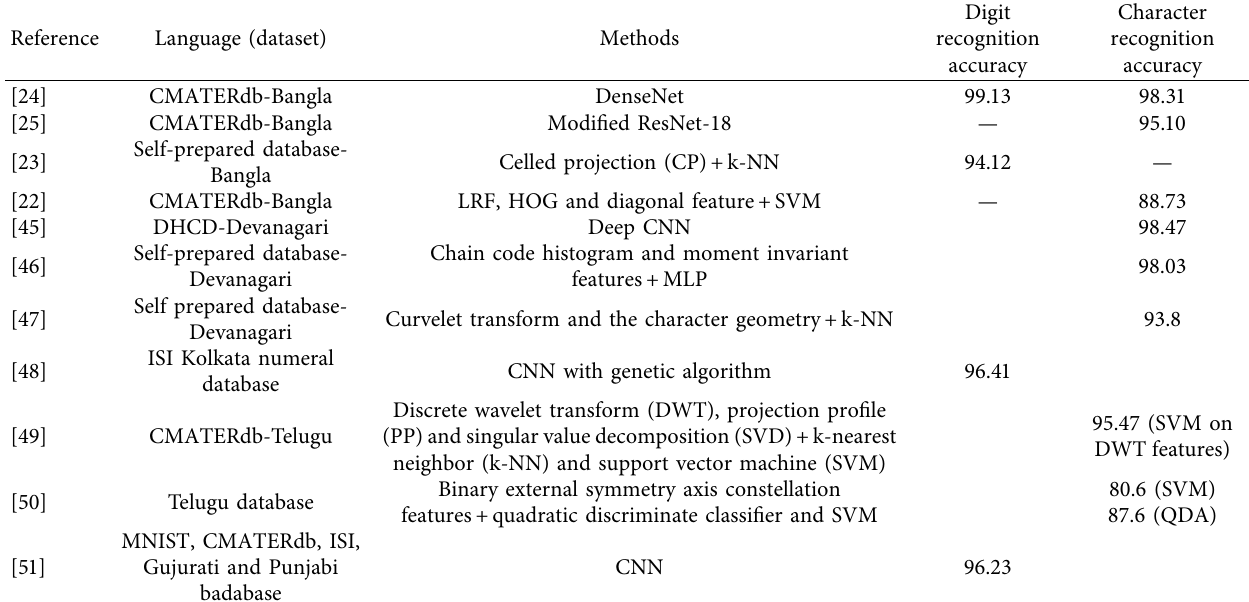
Table 13: A comparative study for multilingual handwritten character and numeral